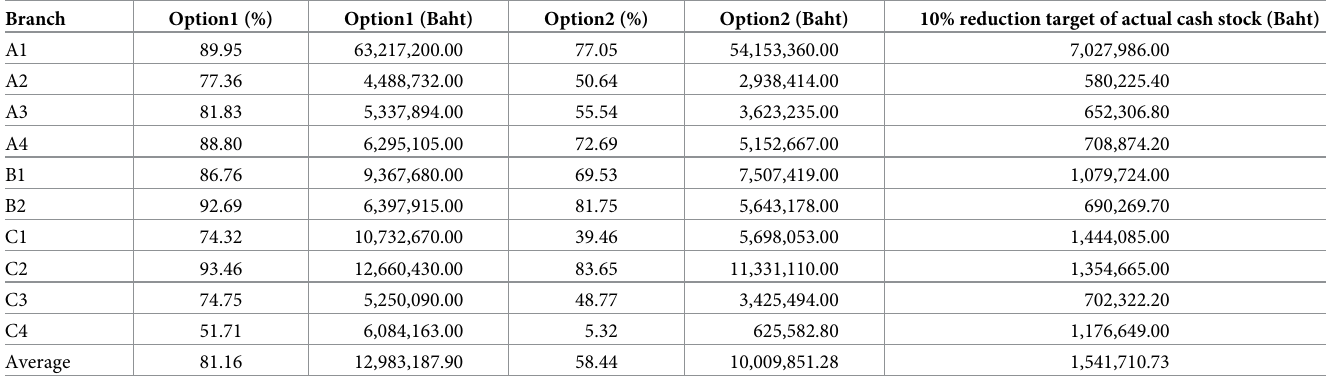
Table 13. Amount of cash stock of various options and 10% reduction target using the regular period.